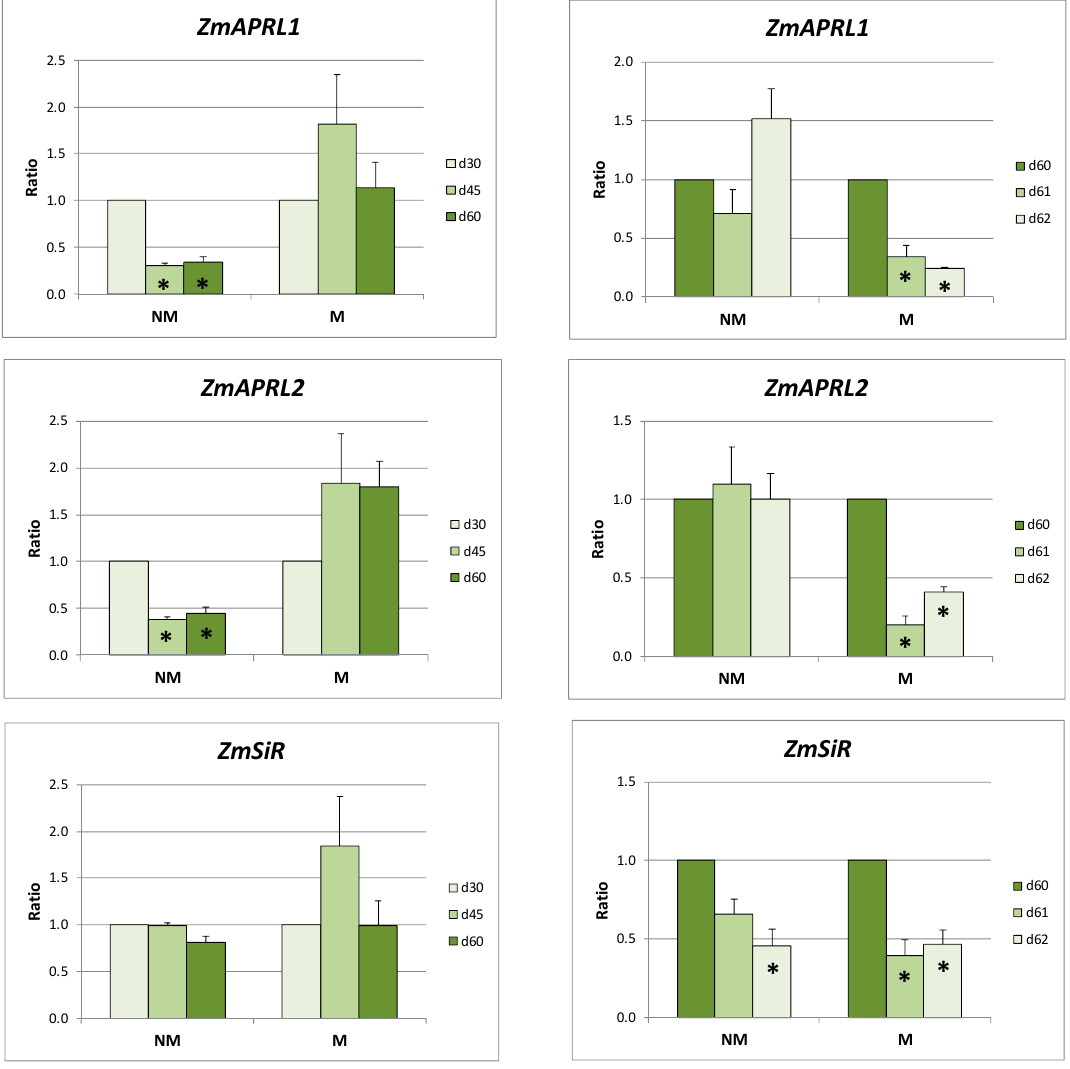
Figure 4. Relative expression ratios (the mean of six biological replicates ± SE) of ZmAPRIL1, ZmAPRL2 , and ZmSiR in the leaves of non-mycorrhizal (NM) and mycorrhizal (M) maize plants before (left column) and after (right column) the supply of sulfate. d30 / d45 / d60 / d61 / d62: days after sowing. Significant differences ( p < 0.05) between the samples and the respective controls are represented by an asterisk (*).